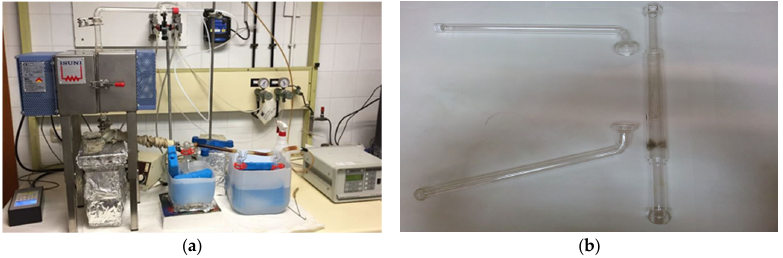
Figure 1. The experimental installation used ( a ) and detail of the quartz reactor and joints ( b ).